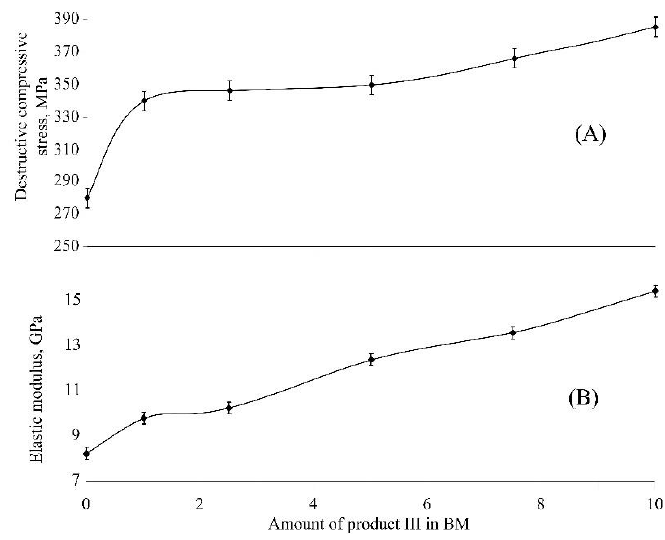
Figure 5. Dependences of ( A ) destructive compressive stress and ( B ) elastic modulus on the content of product III in the compositions.